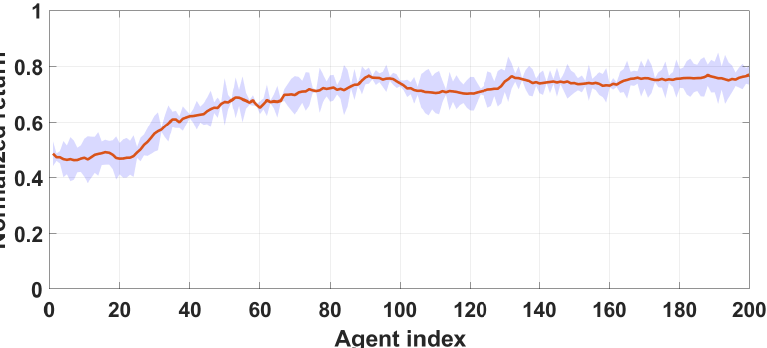
Figure 3. Training results of the DQN agent. Trend of the normalized reward over the evaluated agent index. The red line is the mean while the shaded blue area is the variance over 100 episodes per